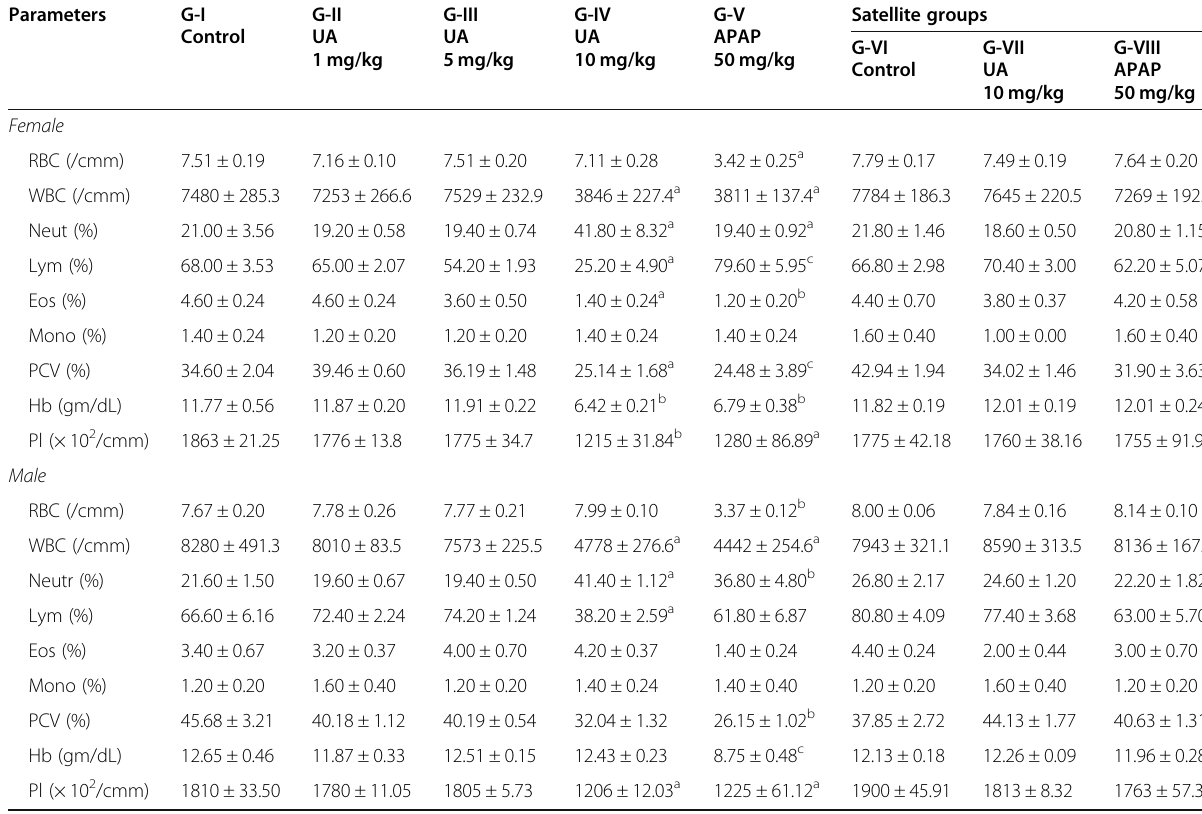
Table 8 Effects of sub-acute oral administration of UA and APAP on selected hematological parameters of Wistar rats ( n = 5/sex)